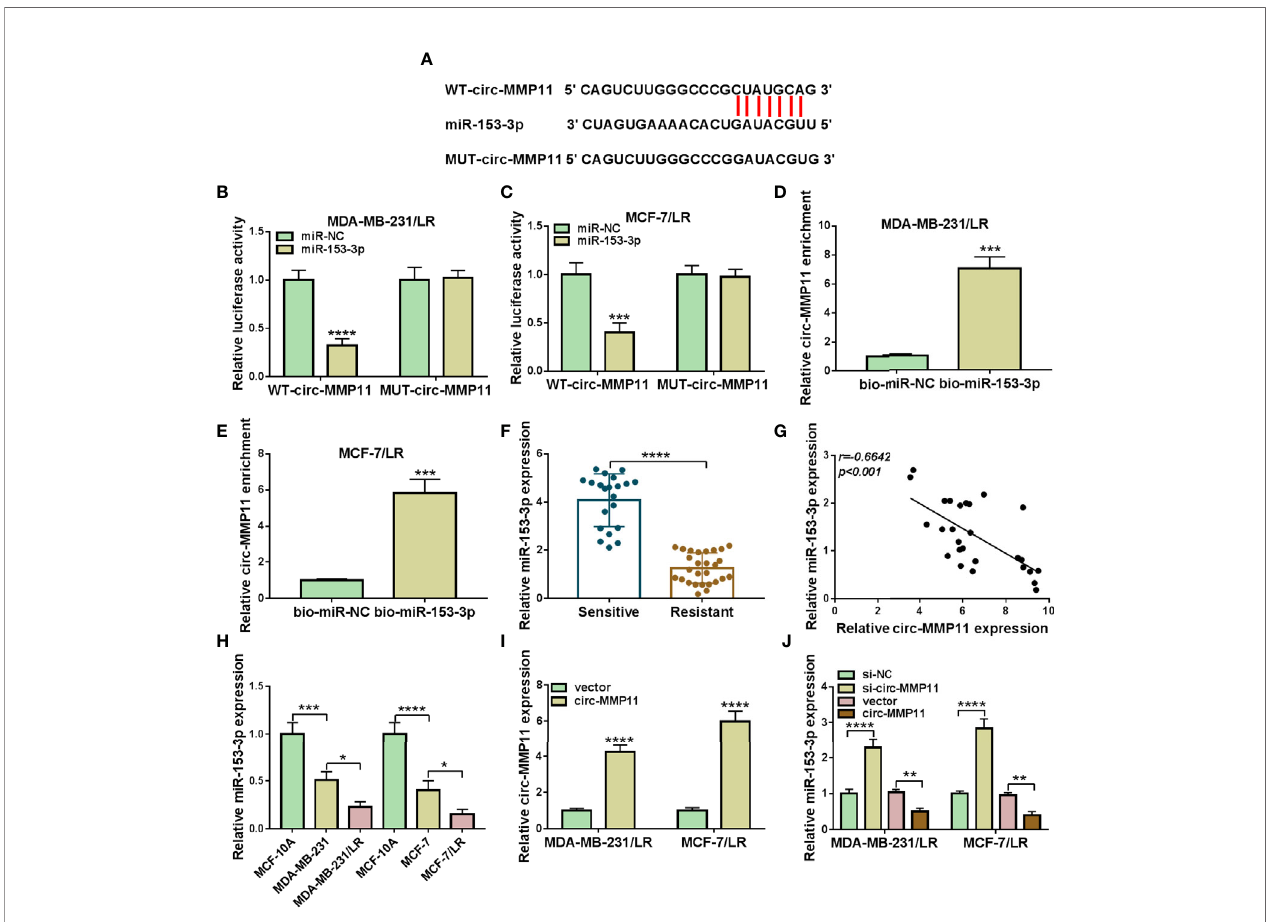
FIGURE 4 | MiR-153-3p was a direct target of circ-MMP11 in LR breast cancer cells. (A) The binding between circ-MMP11 and miR-153-3p was predicated by using circinteractome software. (B, C) Dual-luciferase reporter assay was applied to analyze the prediction in MDA-MB-231/LR and MCF-7/LR cells. (D, E) RNA pull- down assay was conducted to detect the interaction between circ-MMP11 and miR-153-3p. (F) Relative miR-153-3p expression was detected in 21 chemo- sensitive tissues and 27 drug-resistant tissues. (G) Expression correlation between circ-MMP11 with miR-153-3p in drug-resistant tissues was analyzed by using Pearson correlation analysis. (H) Expression level of miR-153-3p was detected in MCF-10A, MDA-MB-231, MDA-MB-231/LR, MCF-7, MCF-7/LR cells. (I) Circ-MMP11 level was measured in MDA-MB-231/LR and MCF-7/LR cells transfected with vector and circ-MMP11. (J) MiR-153-3p level was assessed in MDA- MB-231/LR and MCF-7/LR cells transfected with si-NC, si-circ-MMP11, vector, and circ-MMP11. * P < 0.05, ** P < 0.01, *** P < 0.001, **** P < 0.0001 (Student ’ s t - test or ANOVA with Tukey ’ s tests), circ-MMP11 relative to GAPDH, miR-153-3p relative to